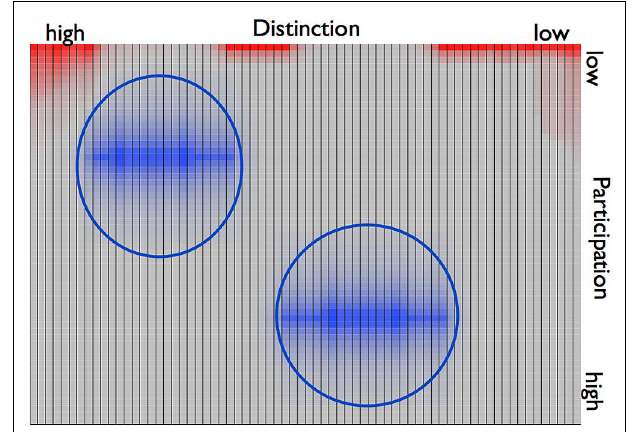
FIGURE 4 | 2D illustration of the joint phase space of the couple described by example 1 . The attractors are depicted in blue, the repellors in red. Attractors are circled showing that there was no overlap of the basins of the two